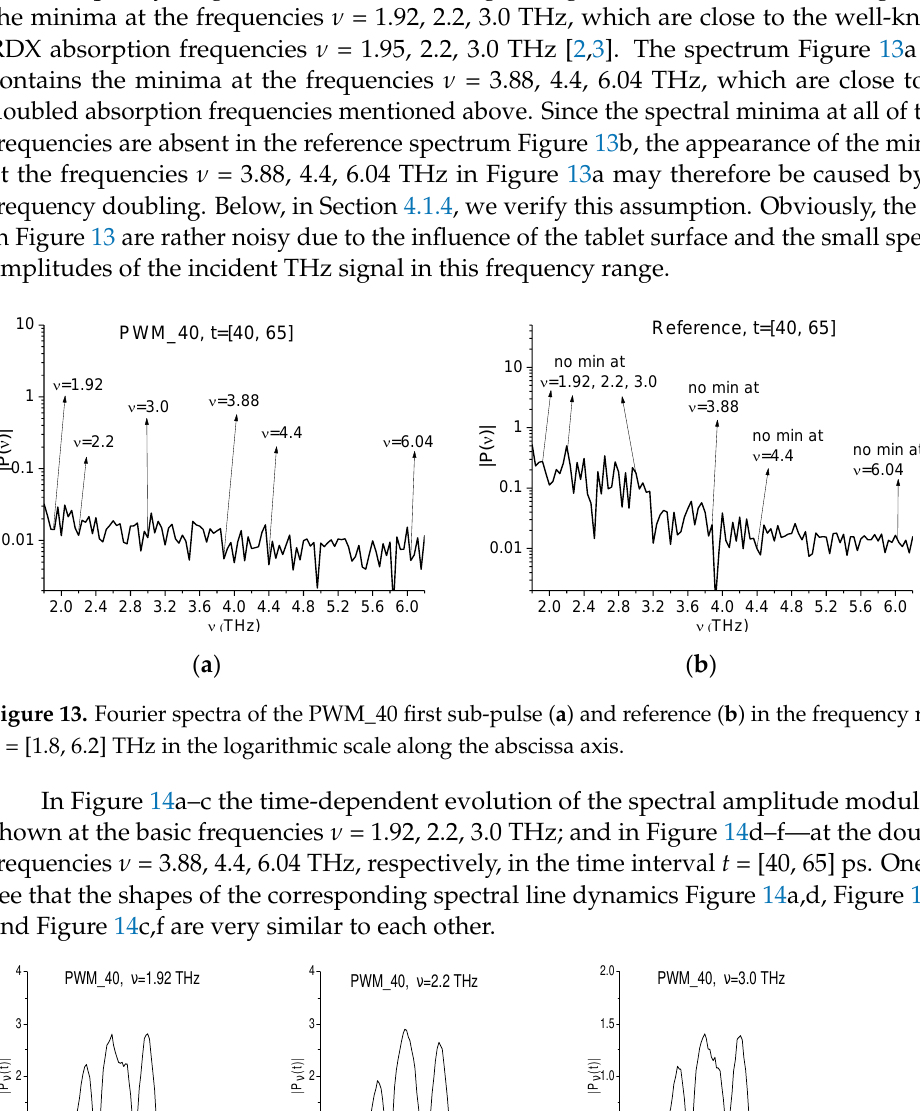
E t with ( 2 )  = 0.1 ( a , b ) and 0.01 ( c ), 0.001 ( d ) in () t r anno r m _